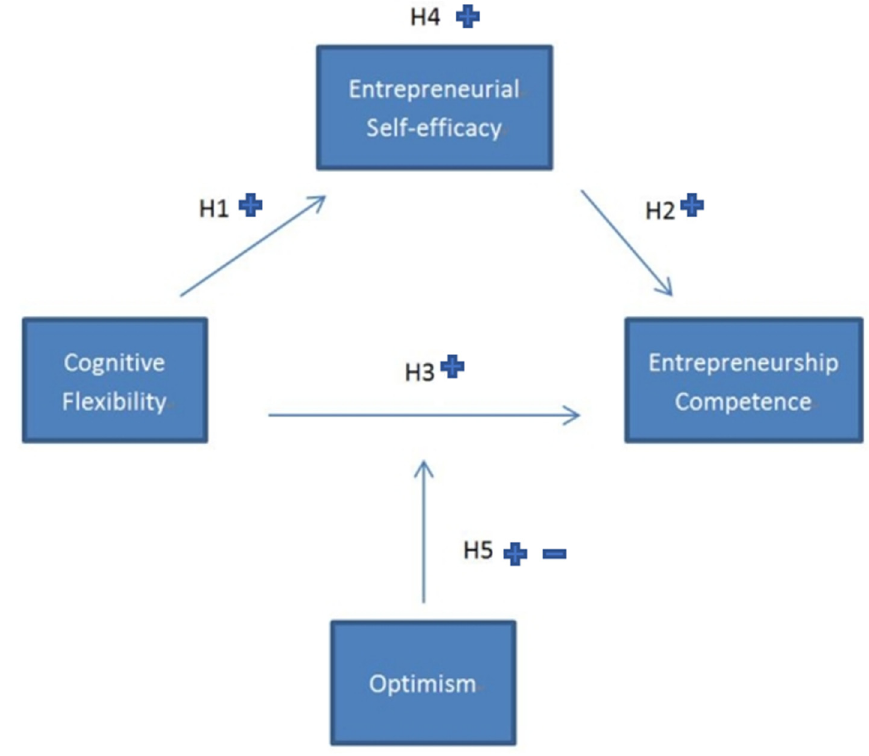
Figure 1. Theoretical model.